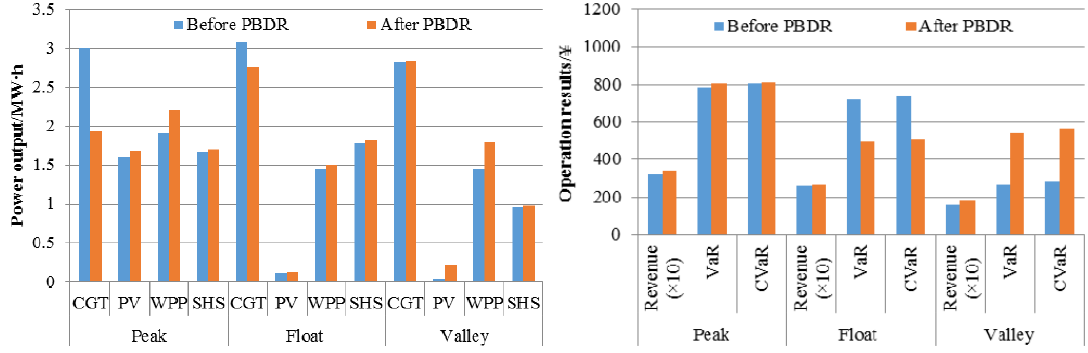
Figure 14. Operation results of VPP before/after PBDR.